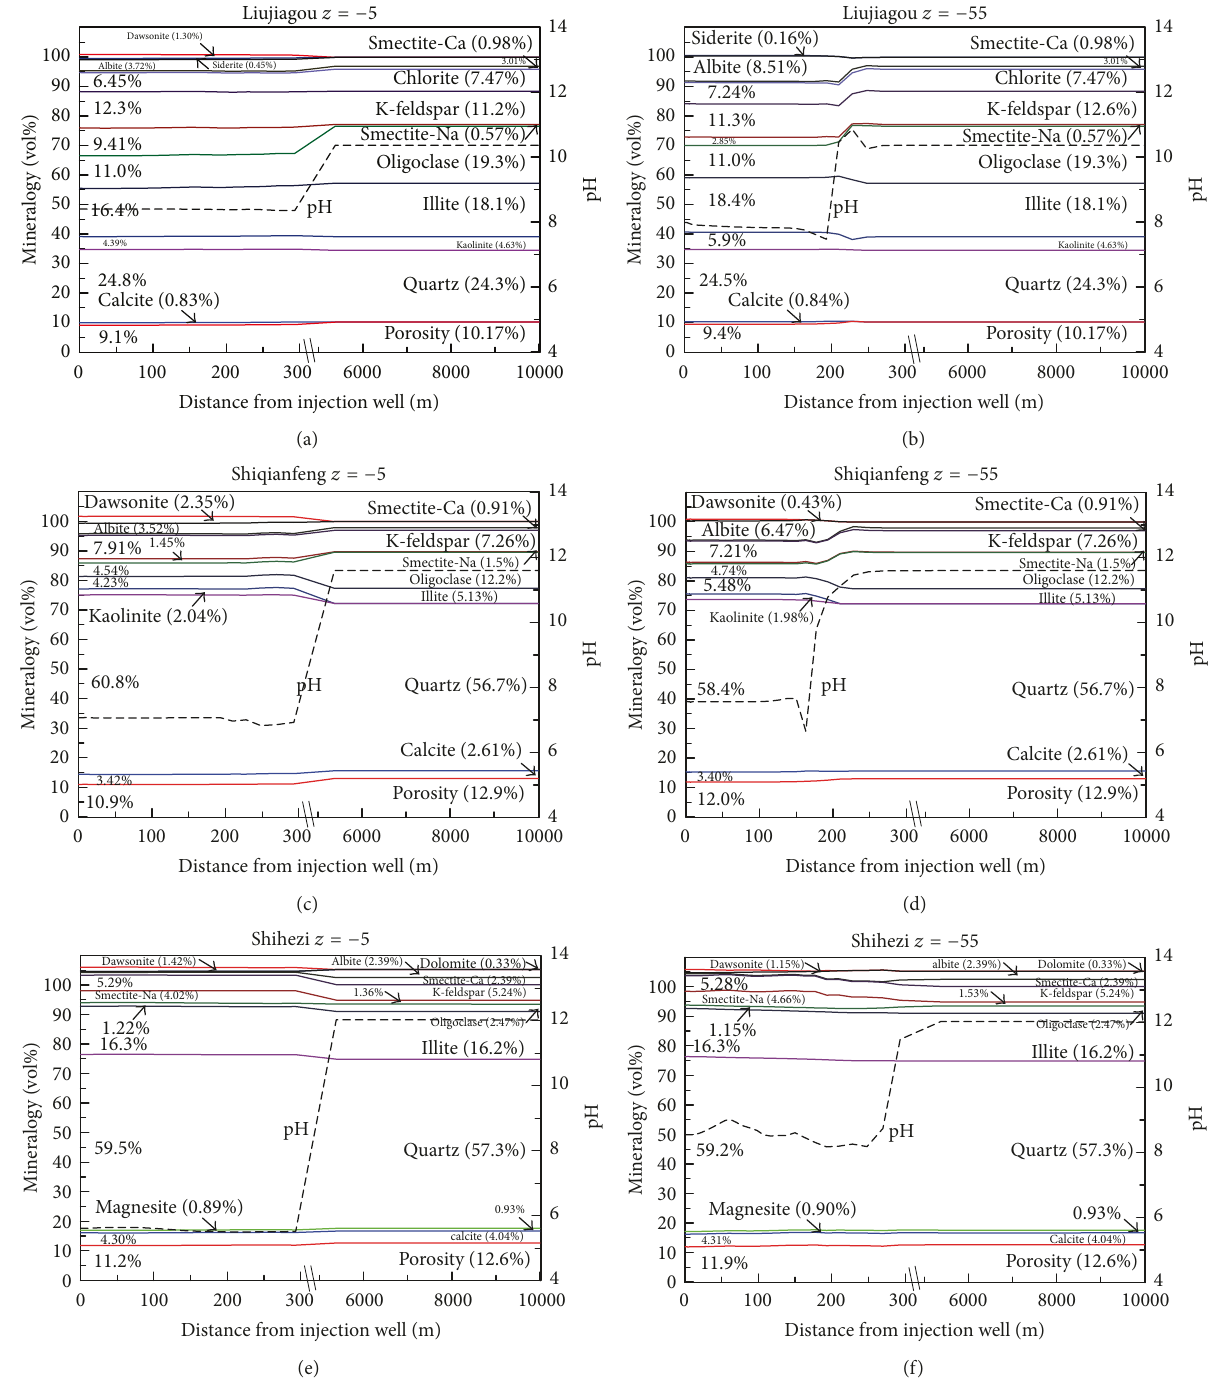
Figure 10: Mineral abundance of the Liujiagou formation (a, b), Shiqianfeng formation (c, d), and Shihezi formation (e, f) at the depths of − 5 m and − 55 m after 10,000 years.